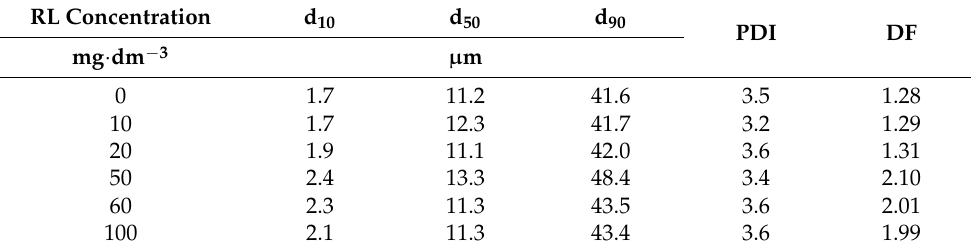
Table 3. Deciles of the particle size distribution (d 10,50,90 ) with a polydispersity index (PDI) and fractal dimension (DF) values for dolomite samples contacted with various concentrations of RL.